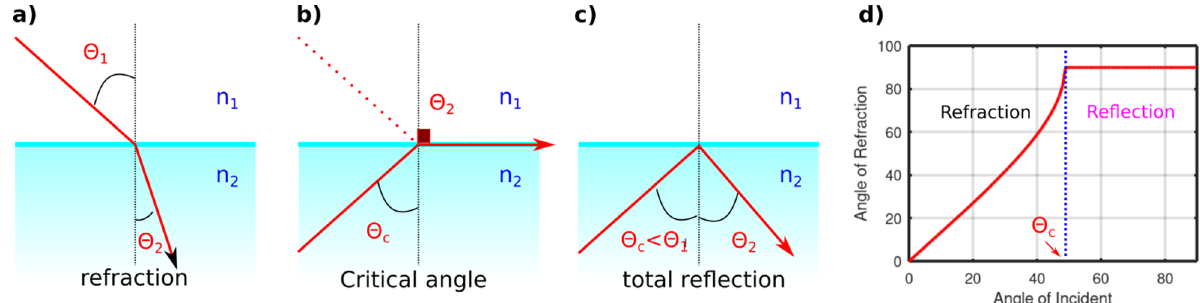
Figure 4. Various conditions for Snell’s law for light reflection/refraction behavior for air/water interface herein. ( a ) from air to water. ( b ) from water to air at critical angle. ( c ) upon total reflection. ( d ) dependence of reflection angle versus incident angle from water to air.